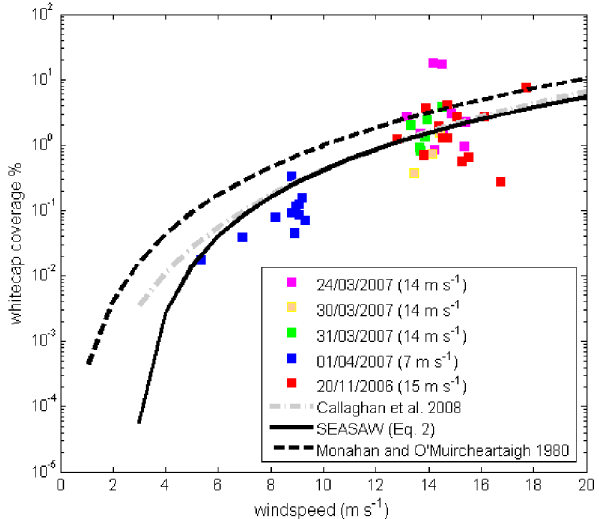
Fig. 7. The SEASAW whitecap estimates during each buoy deploy- ment (symbols), and the whitecap parameterizations from the full SEASAW cruise data set, Callaghan et al. (2008a) and Monahan and O’Muircheartaigh